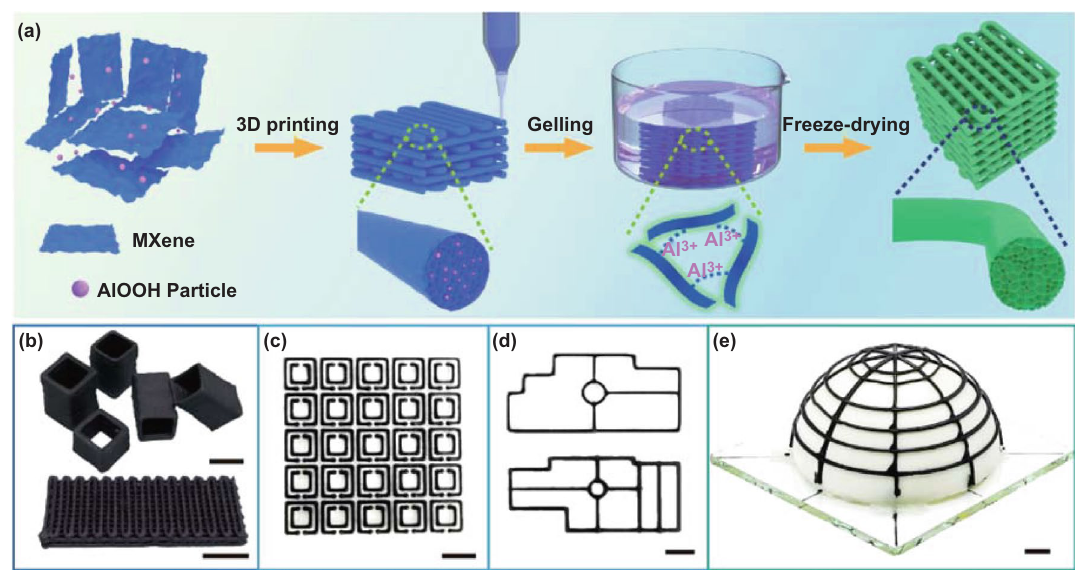
Fig. 1 a Schematic of constructing a freestanding MG frame. b Printed MG cubic frame and “woodpile” microlattice. Printed MG with c dou‑ ble split rings and d the shape of EMI shields in electronic devices. e Adaptive hemisphere framework by direct ink printing. The scale bars in Fig. 1 b‑e is 5